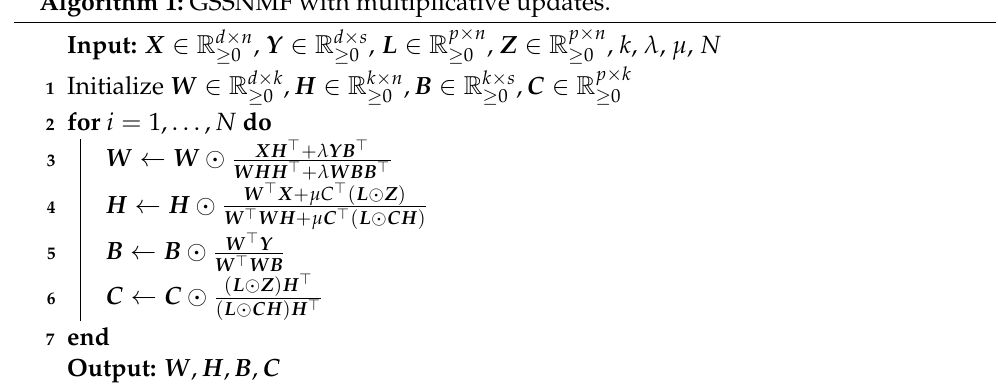
Algorithm 1: GSSNMF with multiplicative